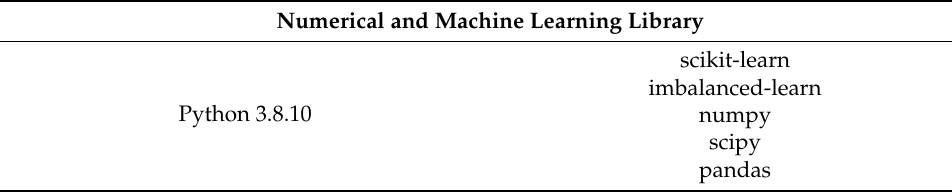
Table 4. Experimental environment for RF-based security